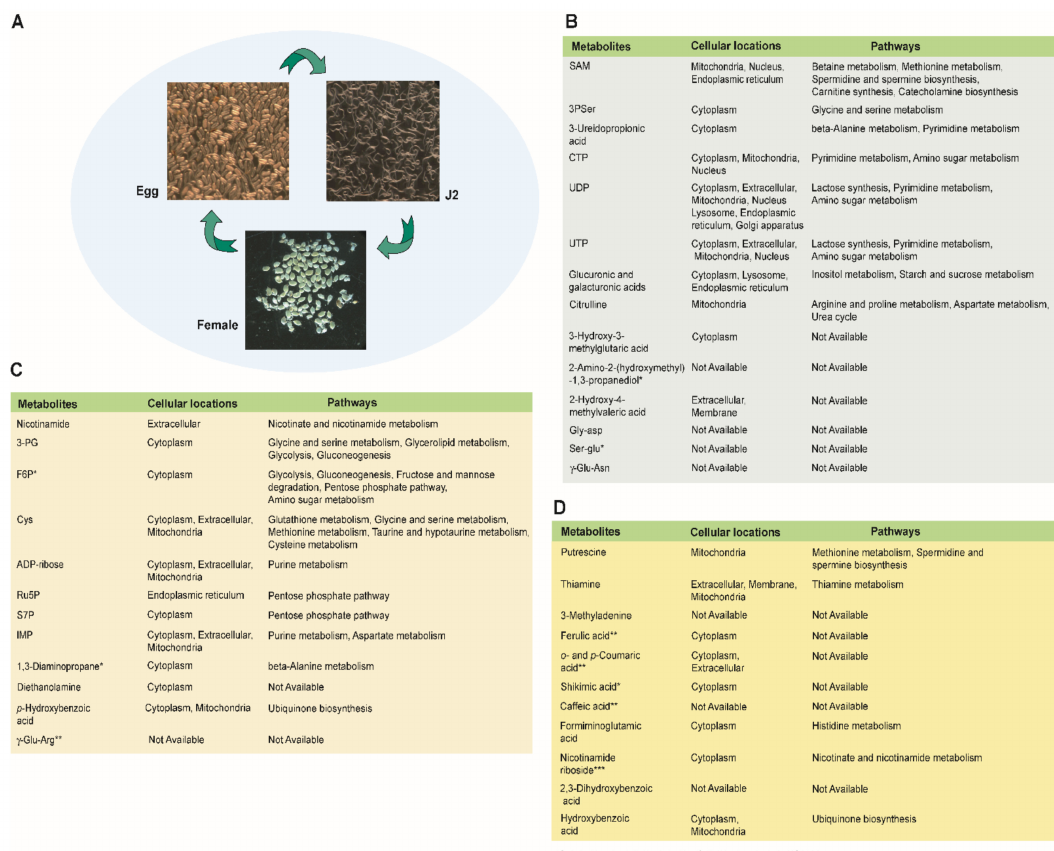
( A ) metabolites involved in the metabolic pathways. ( B ) Metabolites not involved in the biosynthetic pathways. Comparative heat maps were constructed after quantile normalization of relative peak areas in the range of 0.0000 to 0.0.00082. Red indicates increased metabolite levels, green represents decreased levels, and black indicates intermediate levels. The heat map was generated using MeV (ver. 4.9.0) software. HS Egg, H. schachtii egg stage; HS J2, H. schachtii juvenile 2 stage; HS F, H. schachtii female stage; HT Egg, H. trifolii egg stage; HT J2, H. trifolii juvenile 2 stage; and HT female, H. trifolii female stage. Refer to Table S2 for abbreviations of metabolites.